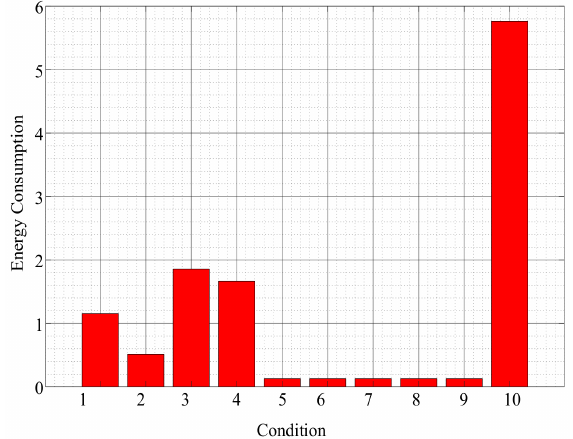
Figure 4. Energy for first line condition.